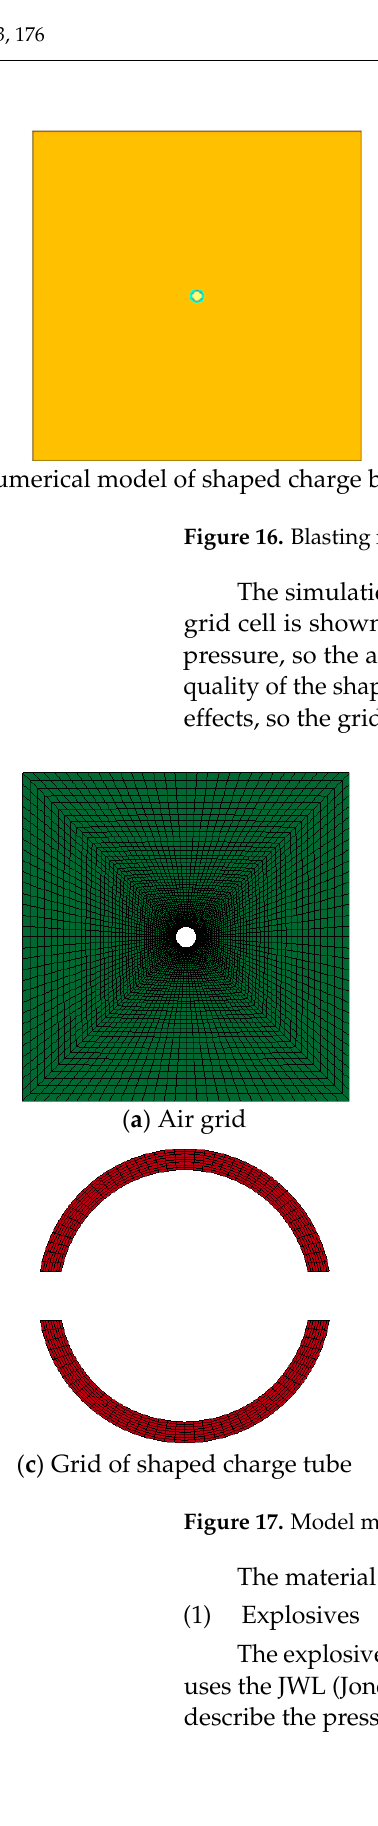
Table 3. Explosive parameters. Explosive Density/g·cm − 3 Detonation Ve- locity/m·s − 1